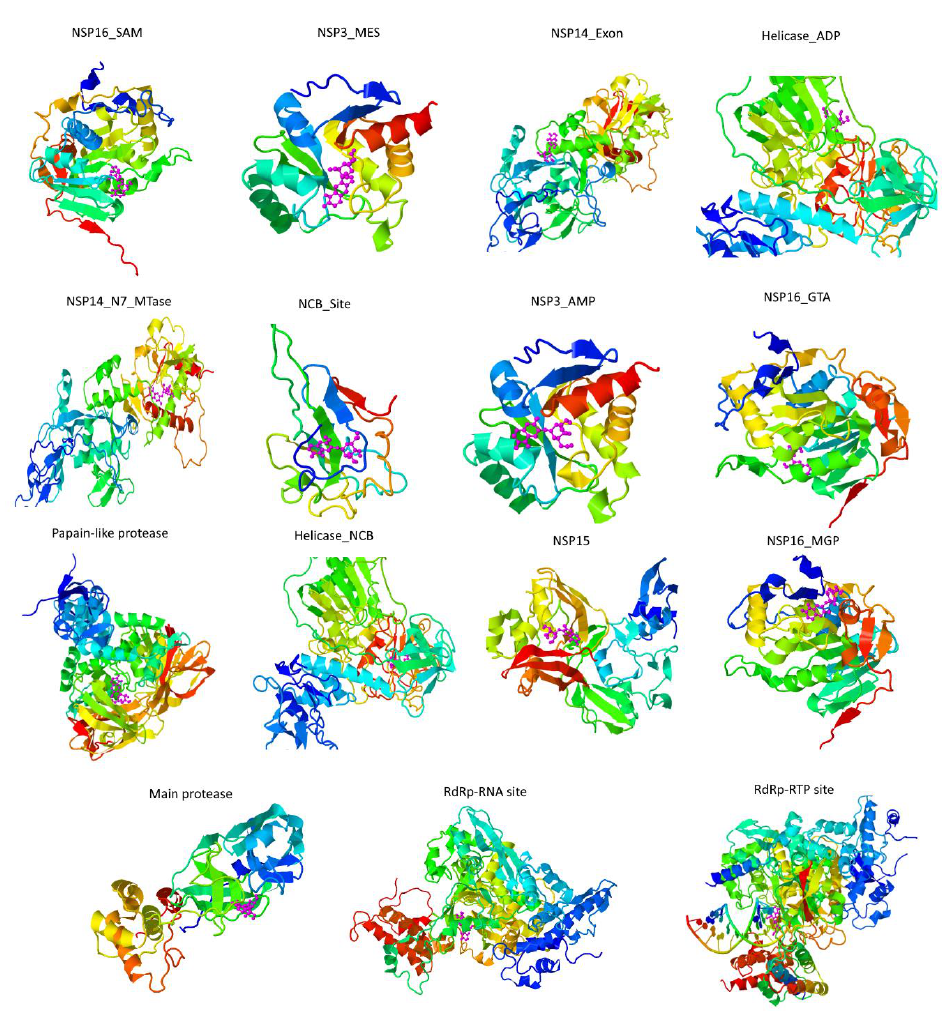
Figure 4. Cichoriin dockings conformations against COVID-19 targets. Cichoriin (magenta) was docked to the main pharmaceutically attractive targets (rainbow ribbon 3D protein structure) of SARS-CoV-2 with the COVID-19 docking server. As depicted in this figure, cichoriin achieves the most stable conformations with against the main protease (papain-like protease), Nsp3 (AMP site), Nsp3 (MES site), RdRp (RTP site), RdRp (RNA site), Helicase (ADP site), Helicase (NCB site), Nsp14 (ExoN), Nsp14 (N7-MTase) and N protein (NCB site).